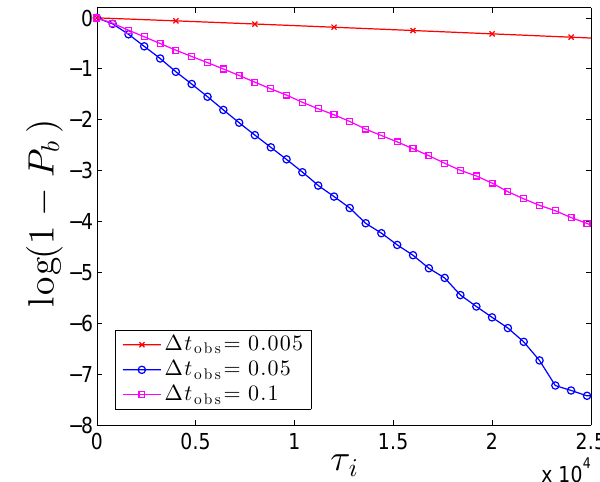
Fig. 3. Log plot of the empirical normalised cumulative probability density function P b (τ i ) of blow-up times τ i for different observa- tion intervals 1t obs for dt = 0 . 0025. We used R o = 0 . 01 and k = 6 ensemble